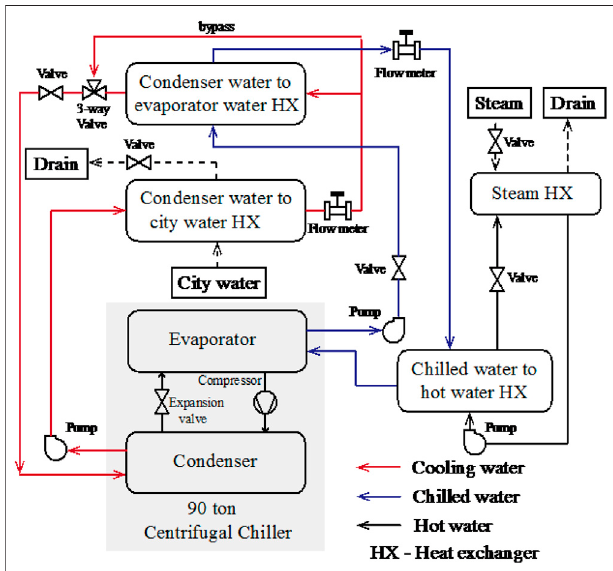
FIGURE 2 | Schematic diagram of the experimental centrifugal chiller reported in ASHRAE RP1043.